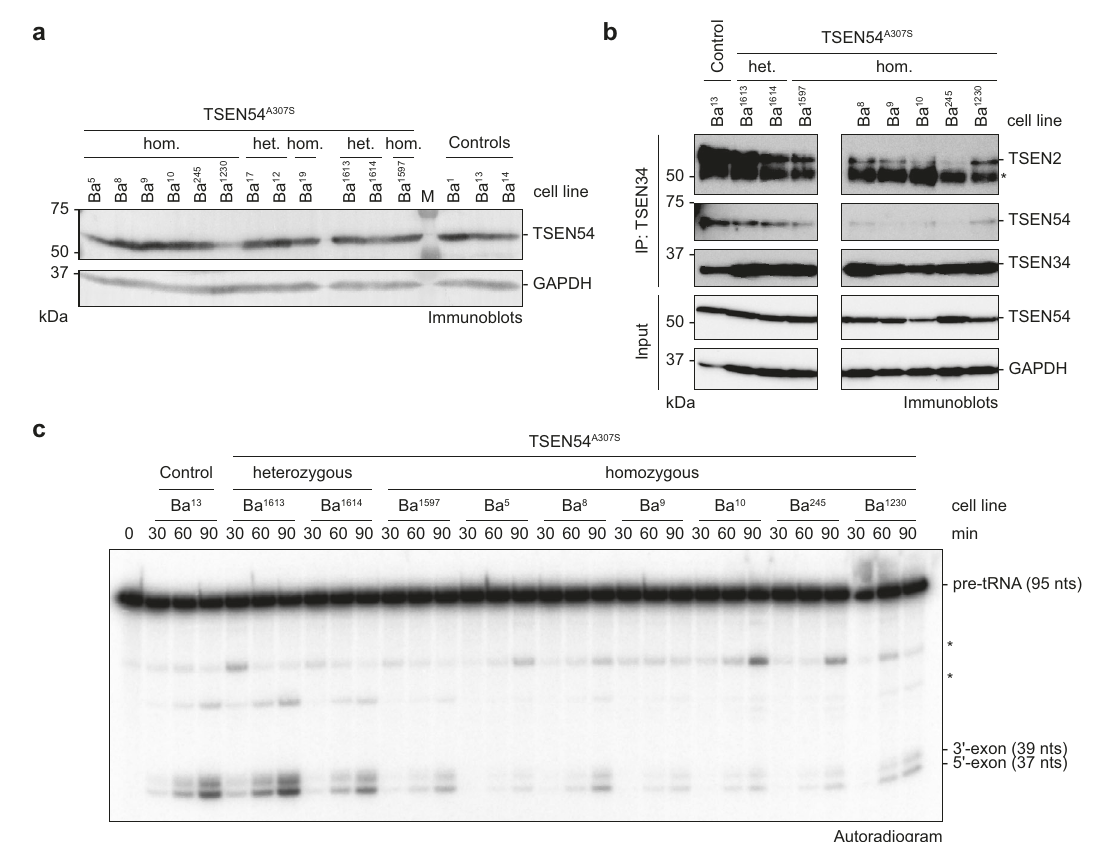
Fig. 6 Reduced pre-tRNA cleavage activity in PCH patient-derived cell extracts is associated with altered composition of TSEN. a Comparison of TSEN54 protein levels between control and heterozygous or homozygous PCH patient fi broblasts analyzed by immunoblotting. GAPDH served as a loading control. M, protein size marker. b Co-immunoprecipitation (IP) assay using an α -TSEN34 antibody with cell lysates derived from control and heterozygous or homozygous TSEN54 c.919 G > T fi broblasts analyzed by immunoblotting. The asterisk indicates the heavy chain of the α -TSEN34 antibody. c On-bead pre-tRNA cleavage assay (time course) with radioactively labeled S.c . pre-tRNA Phe GAA and immunoprecipitated TSEN complexes ( α -TSEN34 antibody- coupled resin) derived from control fi broblasts and from fi broblasts carrying heterozygous or homozygous TSEN54 c.919 G > T mutation shown in ( b ). Unspeci fi c bands are indicated by asterisks. Data are representative of at least two independent experiments. Source data for a , b , and c , are provided as Source Data fi